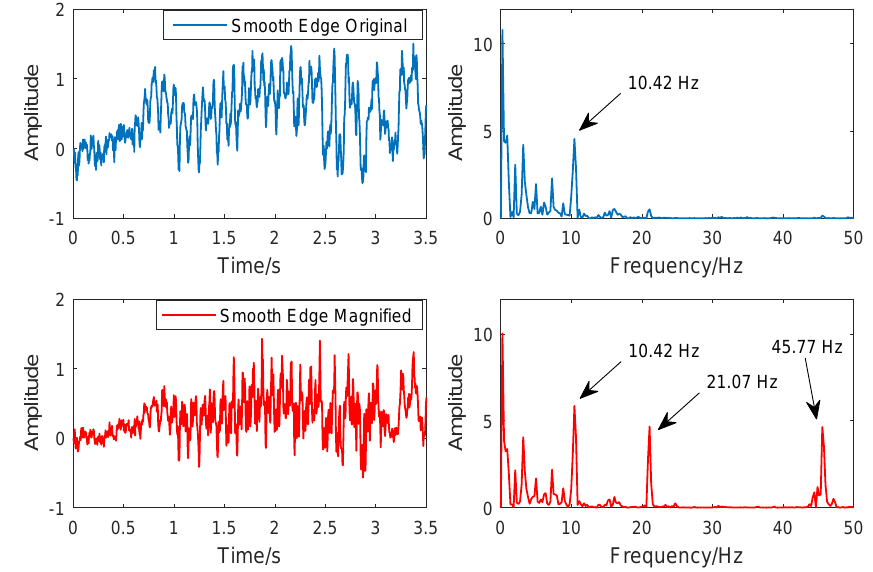
Figure 10. Vibration signals extracted from the original video and the magnified video along the smooth clean edge.